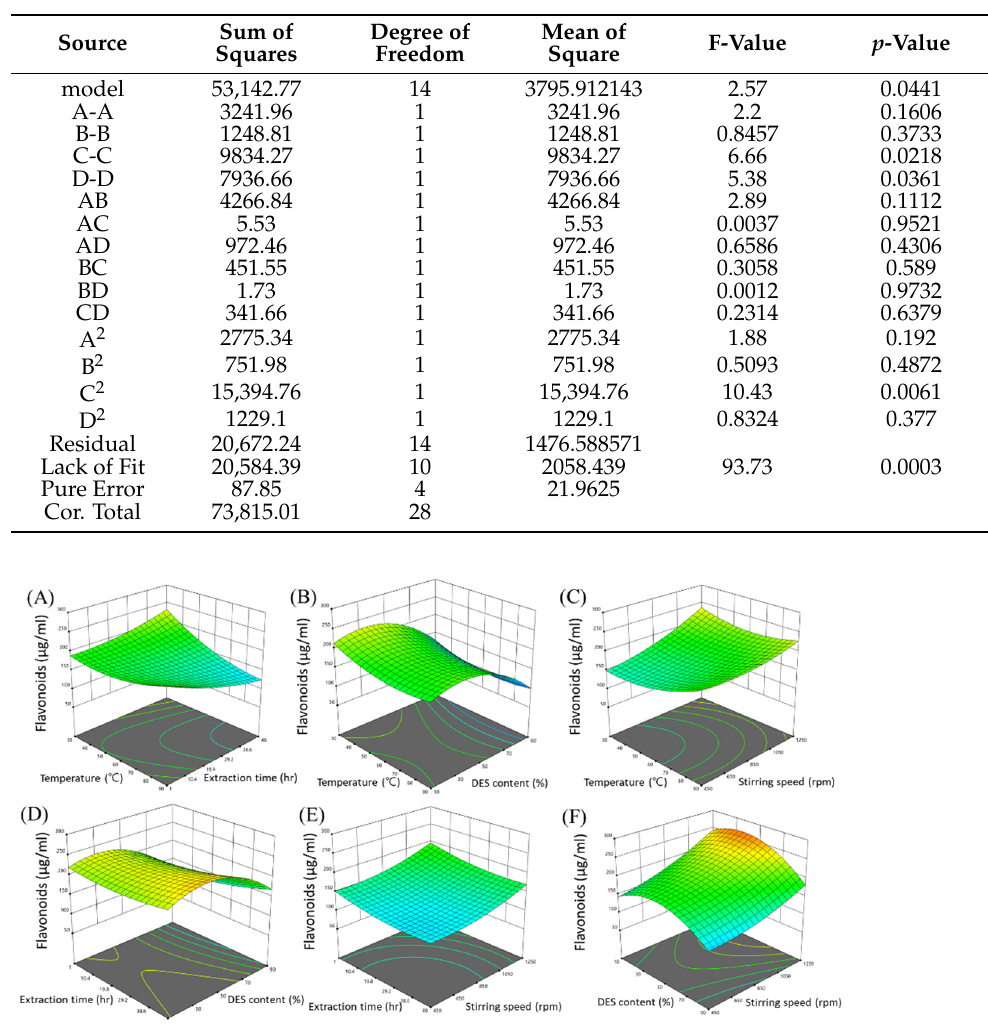
Figure 3. Response surface in Box–Behnken experimental design for the four factors influencing the extraction of flavonoids. ( A ) Effect of temperature and extraction time; ( B ) effect of temperature and DES content; (C) effect of temperature and stirring speed; ( D ) effect of extraction time and DES content; ( E ) effect of extraction time and stirring speed; and ( F ) effect of DES content and stirring speed.